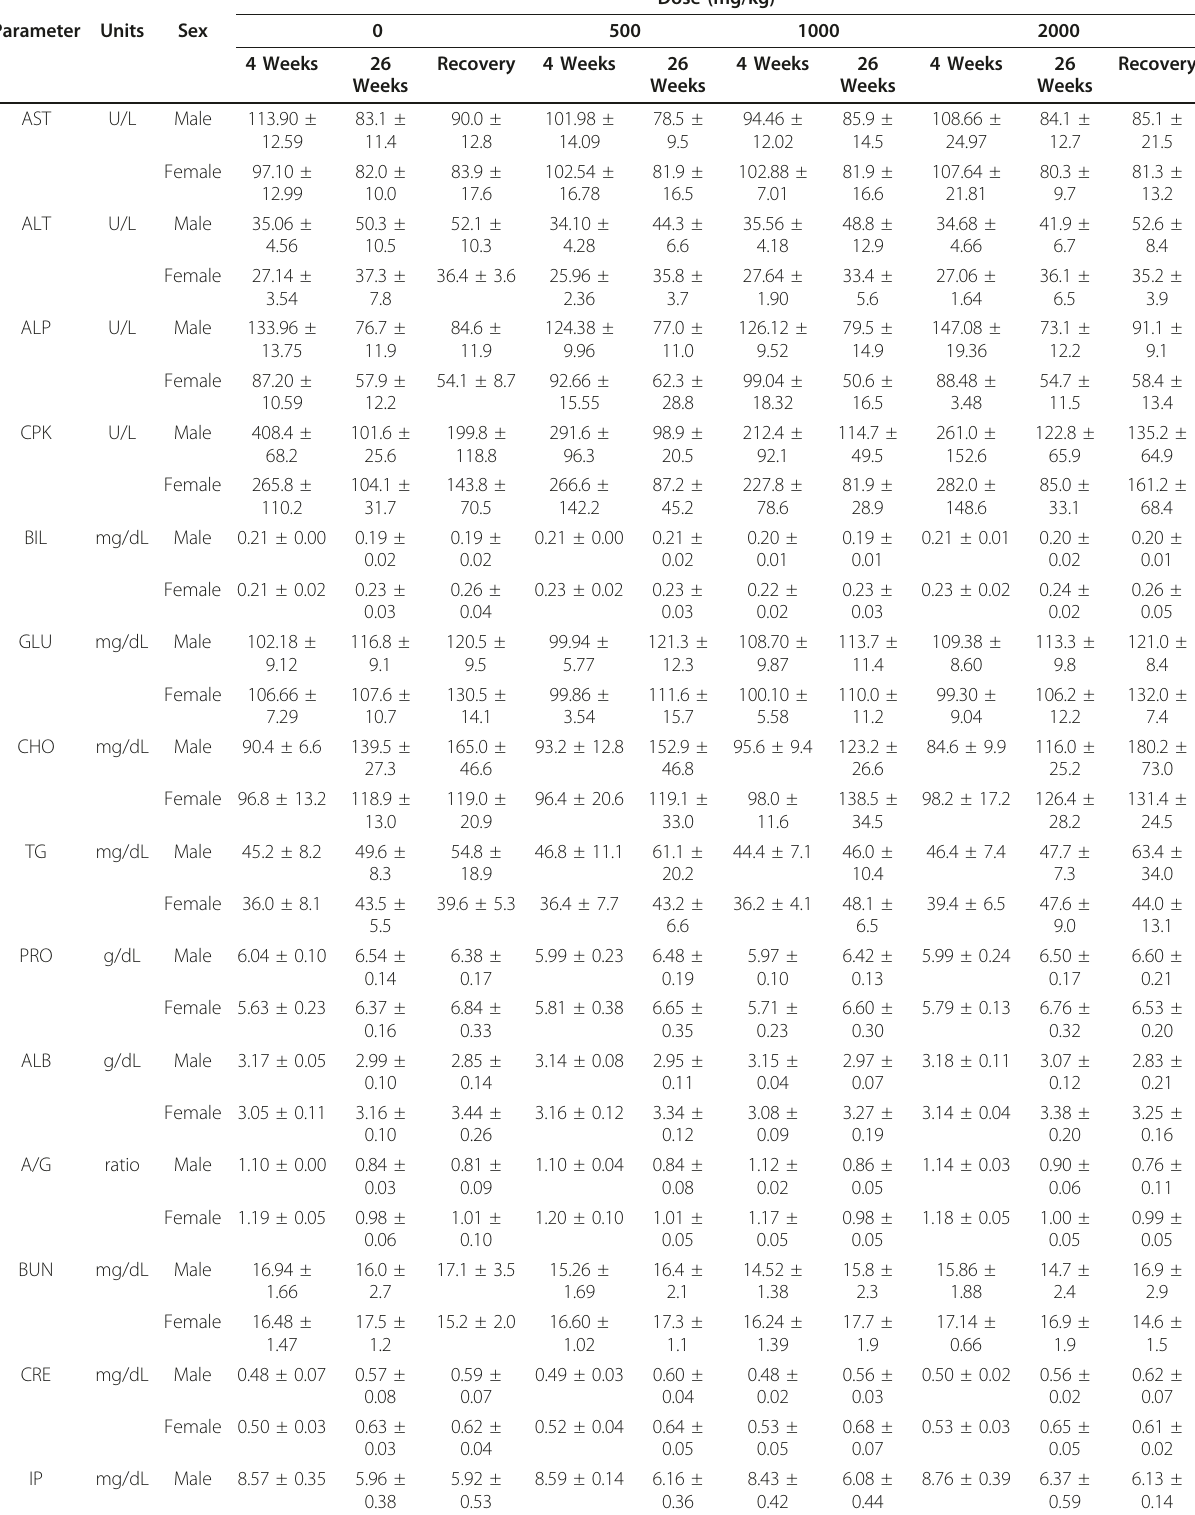
Table 4 Serum biochemical values in rats orally treated with